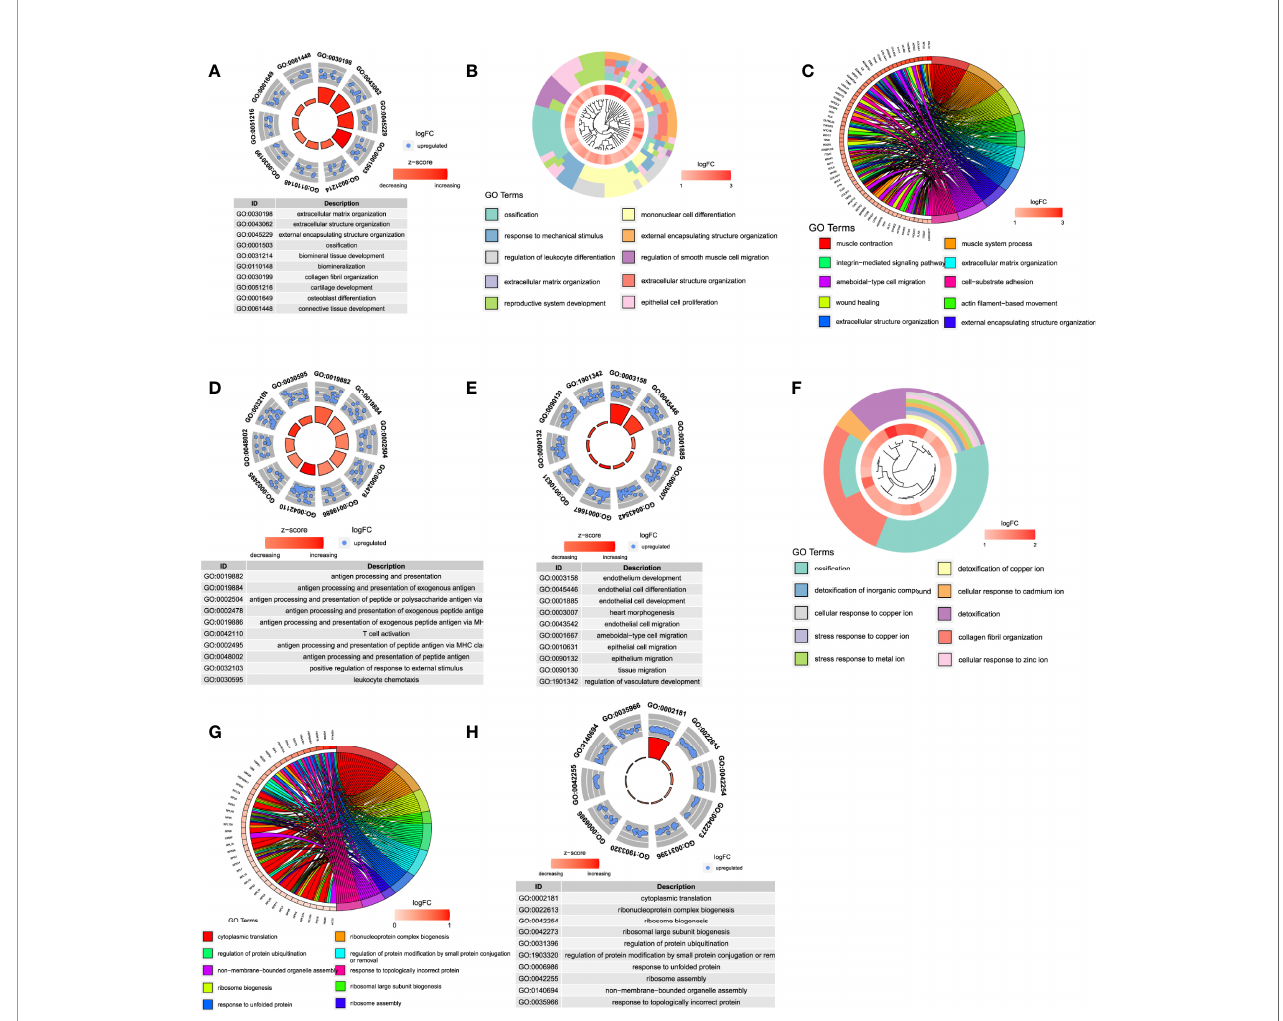
FIGURE 7 | Functional enrichment analysis of different cell populations. (A – H) , The top 10 function enrichment analysis for NPMSC, stromal cell, smooth muscle cell, blood cell, endothelial cell, homeostatic chondrocytes, regulatory chondrocytes, and effector chondrocytes,